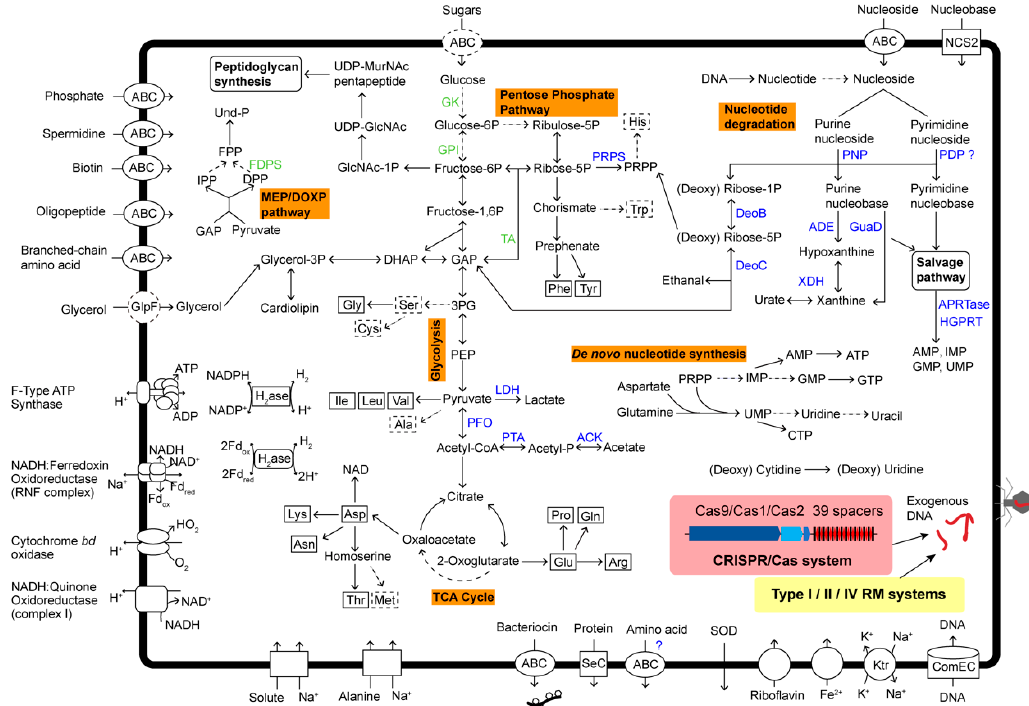
Figure 4. The predicted model of metabolism in Ca. Bathyoplasma sp. NZ. Absent elements of metabolic pathways and transporters are shown in dotted lines. Enzymes that were retained and lost in the genome of BNZ are presented in blue and green, respectively. Abbreviation: GAP, glyceraldehyde 3-phosphate; DHAP, dihydroxyacetone phosphate; 3PG, 3-phosphoglycerate; PEP, phosphoenolpyruvate; PRPP, phosphoribosyl pyrophosphate; IPP, isopentenyl diphosphate; FPP,